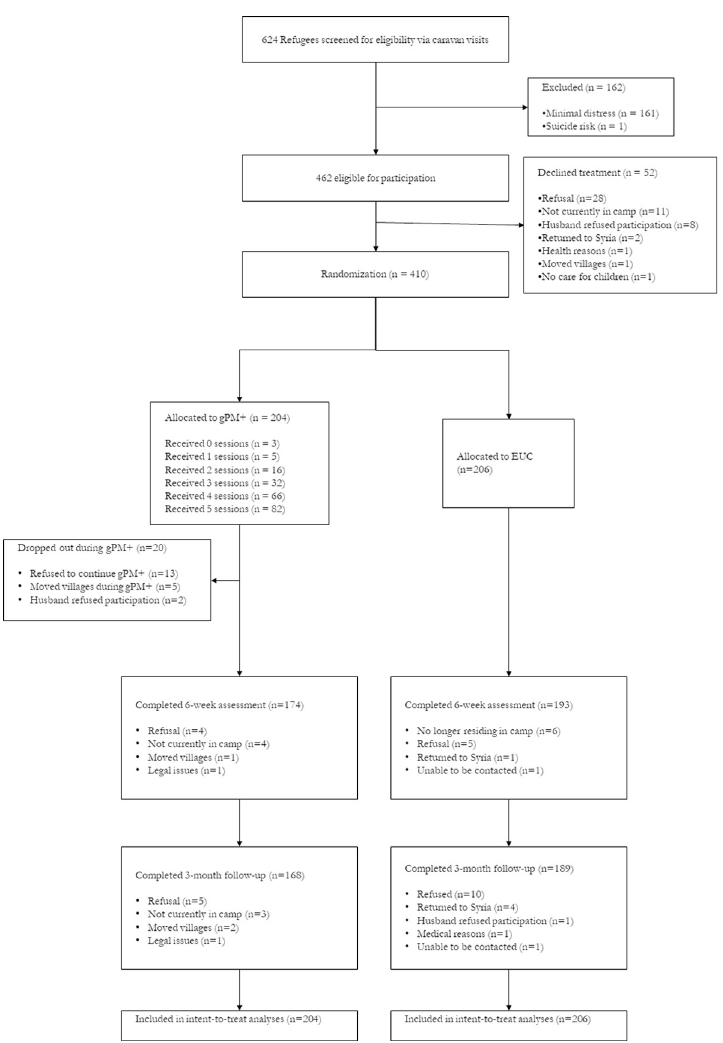
Fig 1. Flow diagram of progress through phases of a randomized trial comparing the group problem management plus intervention vs EUC in Syrian refugees in Azraq Refugee Camp, Jordan. Five participants completed the 3-month follow-up who did not complete the posttreatment assessment. EUC AU : AbbreviationlistshavebeencompiledforthoseusedinFigs 1 and 2 : Pleaseverifythatallentriesarecorrect : , enhanced usual care; gPM+, Group Problem Management Plus.